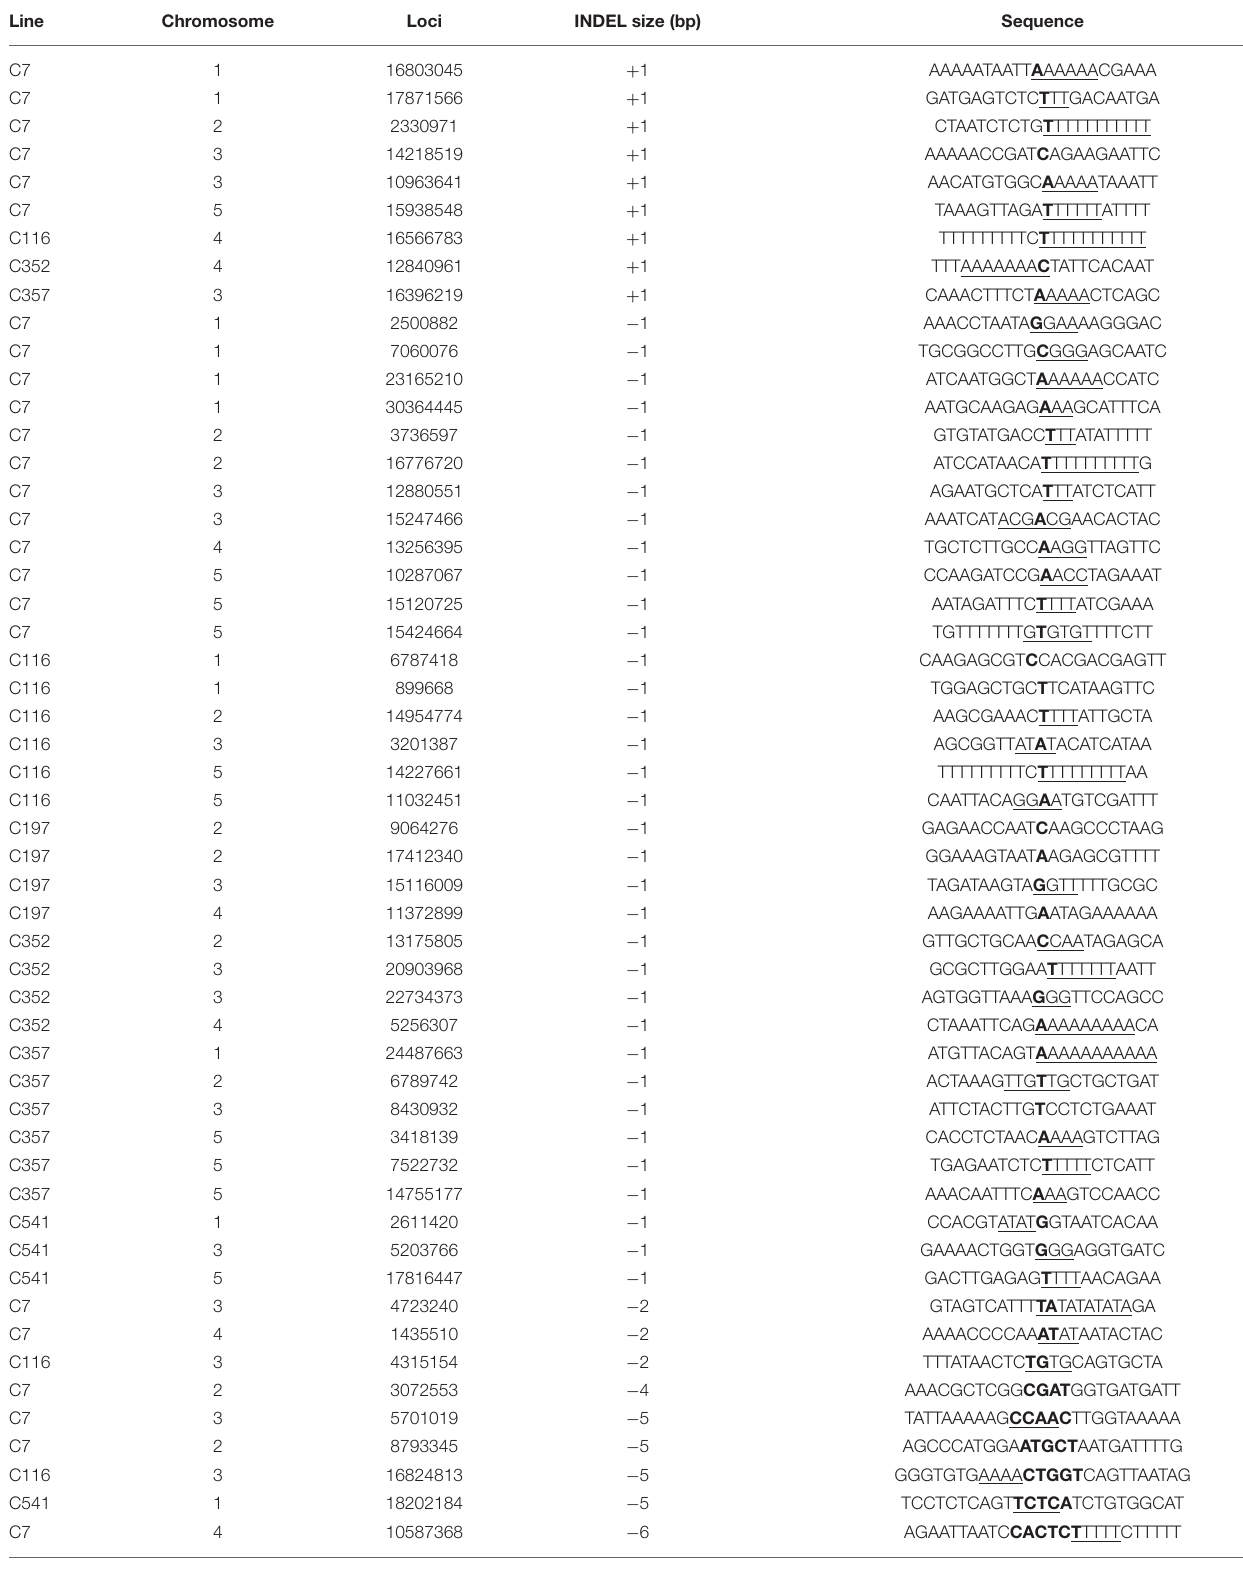
TABLE 4 | Flanking sequences analysis of the small INDELs in six randomly selected re-sequenced lines.